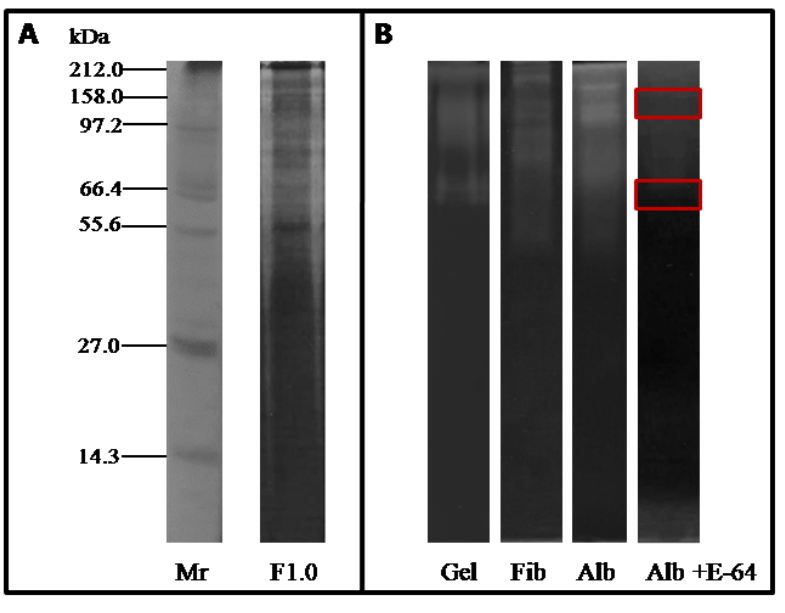
Figure 2. SDS-PAGE profile of fraction F1.0 proteins and in-gel protease assay (zymography). ( A ) Electrophoretic analysis in polyacrylamide gel (15%) of fraction F1.0 of C. urens . Lane Mr: molecular weight marker; Lane F1.0: fraction F1.0 of C. urens treated in non-reducing buffer. The gels were stained with silver staining; ( B ) Zymogram gels. To assess the proteolytic activity by zymogram technique, solution of 15% polyacrylamide was copolymerized with different substrates. After polymerization, the fraction F1.0 was applied to the gels at a concentration of 1.5 µg/µL, and the electrophoretic run was developed. Lane Gel: copolymerized gelatin; Lane Fib: copolymerized fibrinogen; Lane Alb: copolymerized albumin. Lane Alb + E-64: Inhibition of F1.0 at concentration of 1.5 µg/µL by E-64 1 mM in zymogram with albumin co-polymerized. The gels were stained with Coomassie brilliant blue